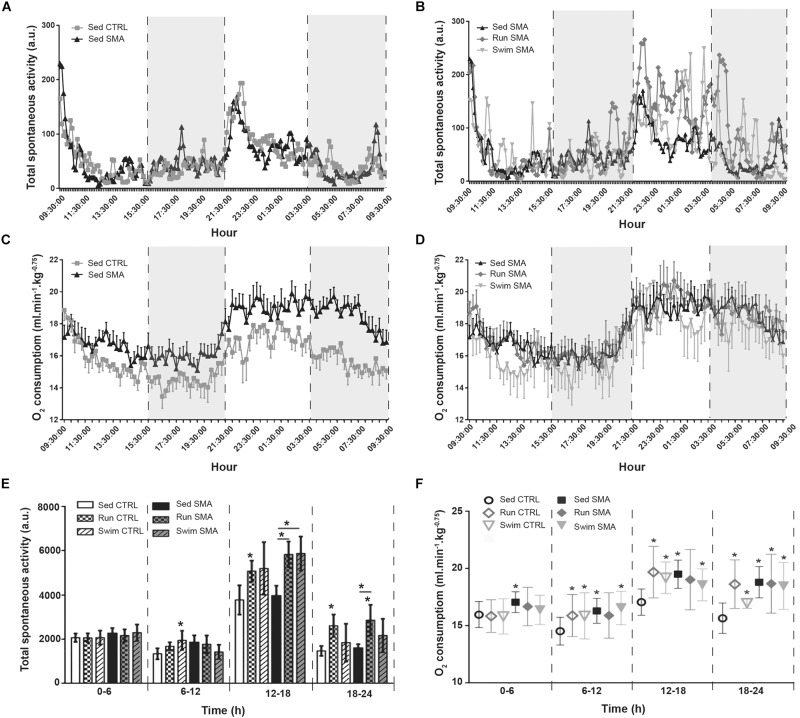
Oxymetry and spontaneous activity analysis in sedentary and trained SMA and control mice: (A,B) 24 h spontaneous activity of (A) sedentary control and SMA mice and (B) Sed SMA compared to Run SMA and Swim SMA mice at 12 months of age. Black dotted lines and gray background delimit periods of 6 h (9 h 30–15 h 30, 15 h 30–21 h 30, 21 h 30–3 h 30 and 3 h 30–9 h 30). (C,D) 24 h dioxygen consumption of (C) sedentary control and SMA mice, and (D) Sed SMA compared to Run SMA and Swim SMA mice at 12 months of age. (E,F) Quantification of spontaneous activity (E) and oxygen consumption (F) according to periods of 6 h from 12 months old sedentary and trained control and SMA mice (n = 12 for sedentary mice, n = 12 for Run CTRL, n = 8 for Run SMA and n = 6 for Swim mice). ∗ and -∗- indicated significance relative to sedentary control and SMA mice, respectively (with P < 0.05).